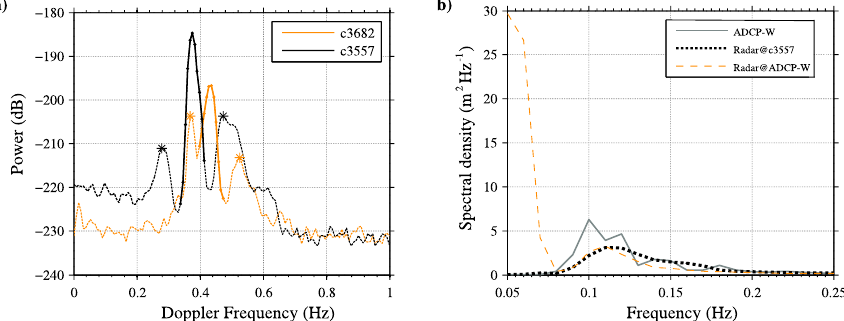
Figure 12. Radar measurement affected by antenna sidelobes: ( a ) The Doppler spectra measured at 14 ◦ (black line) and 45 ◦ (orange line) from Perranporth’s normal. The first-order region of each spectrum is emphasized with a full line. The stars indicate the identified second order peaks. ( b ) The frequency spectra obtained at the same two cells, and measured by the ADCP-W, located at cell